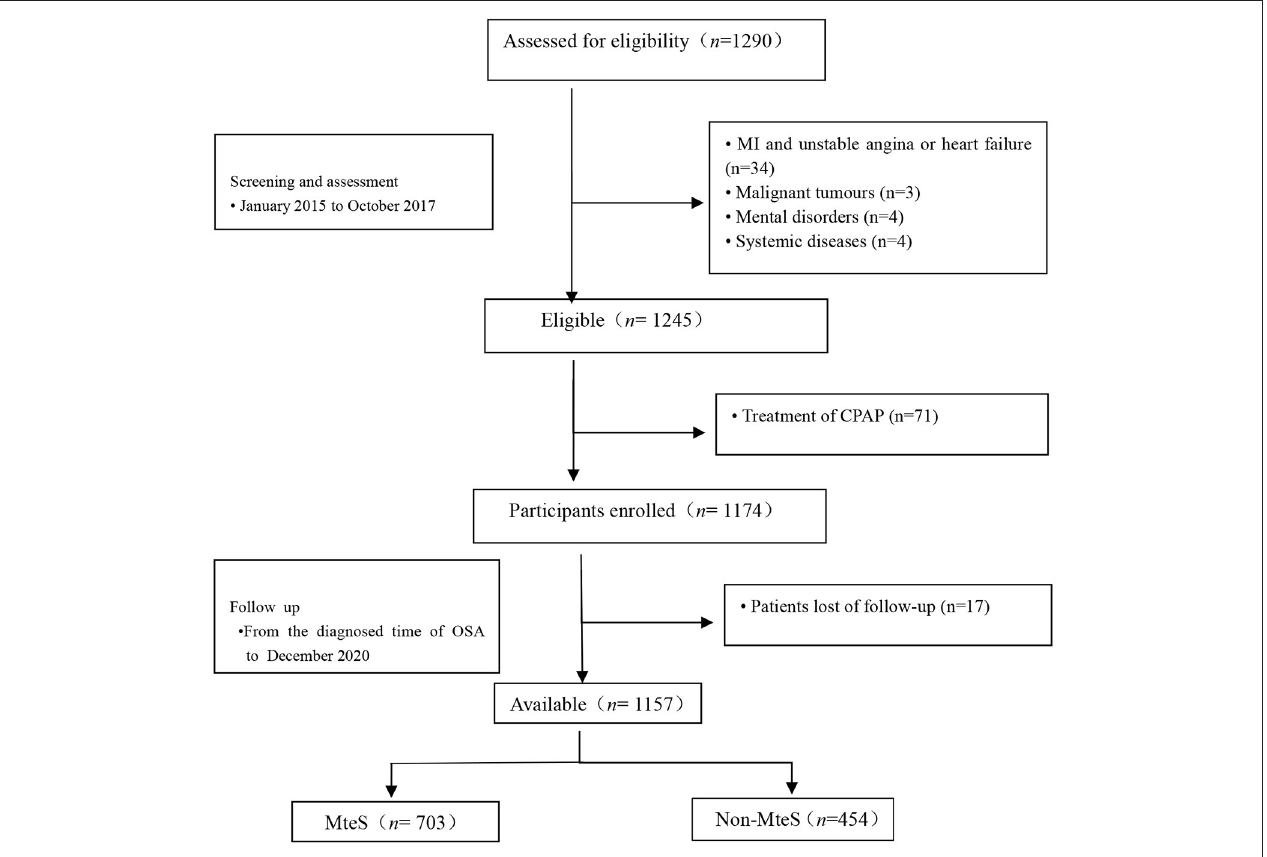
FIGURE 1 | Study flowchart. MteS, metabolic sydrome; CPAP indicates continuous positive airway pressure; MI, myocardial